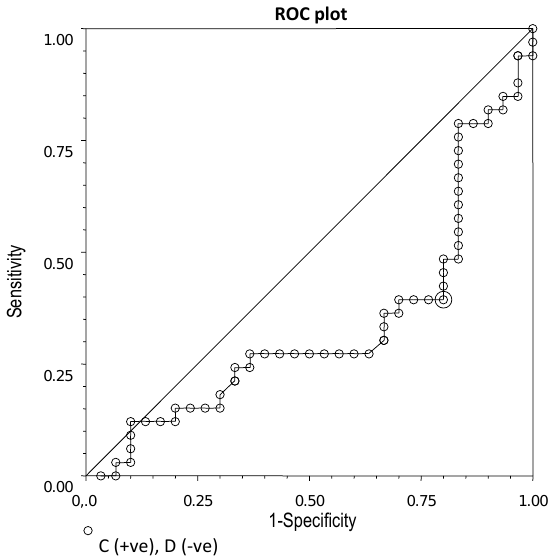
Figure 6. ROC plot for chemerin concentrations (cut-off point: 232.8 ng/mL; sensitivity: 0.60; specificity: 0.80; efficiency: 0.64).